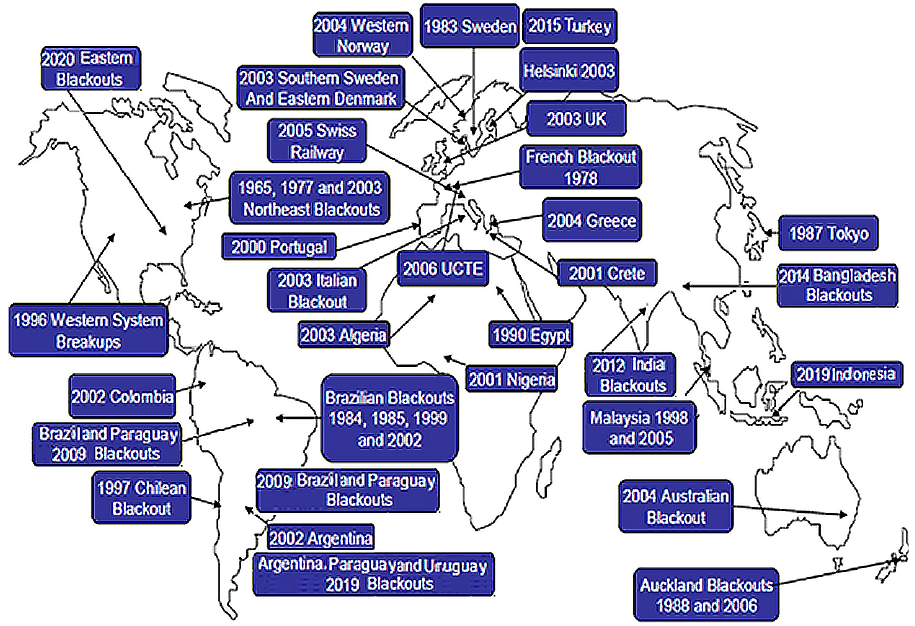
Figure 1. Worldwide major system disturbances and blackouts in the past several